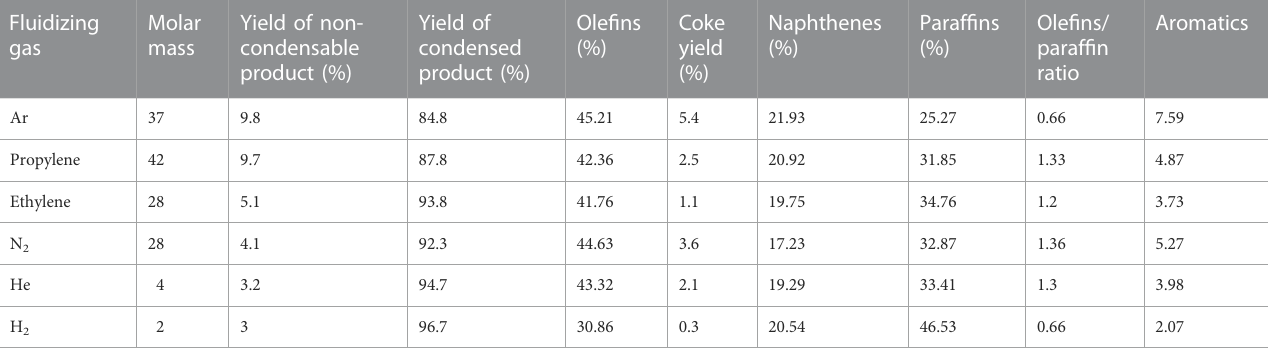
TABLE 9 The effect of carrier gas on the product yield and the condensed product composition (Abbas-Abadi et al., 2014). Fluidizing